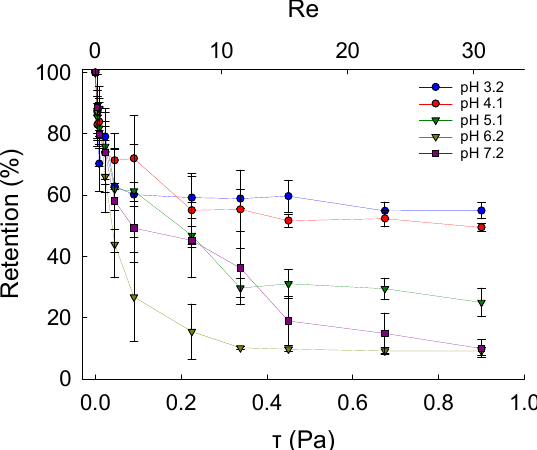
Figure 6. Retention performance of LM microcapsules onto thin PET model films as a function of shear stress ( τ ) and Reynolds number (Re; secondary x -axis) at different environmental pH.